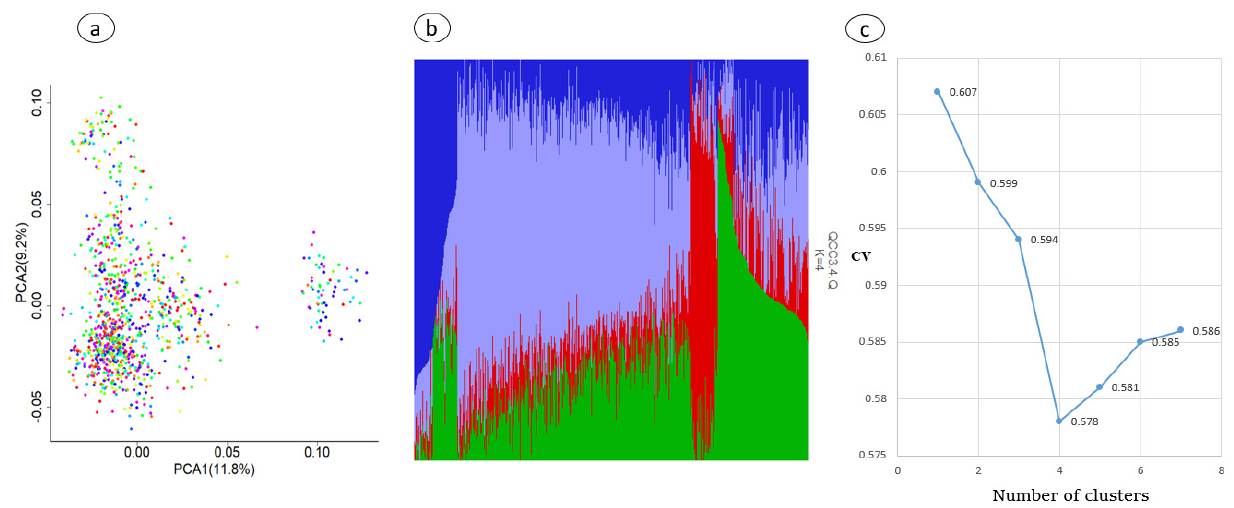
Figure 2. Population structure for experimental population (1000 cows) raised at four farms. ( a ) Principal component analysis. ( b ) Admixture analysis. ( c ) Cross-validation errors across 21 ancestral genetic clusters.